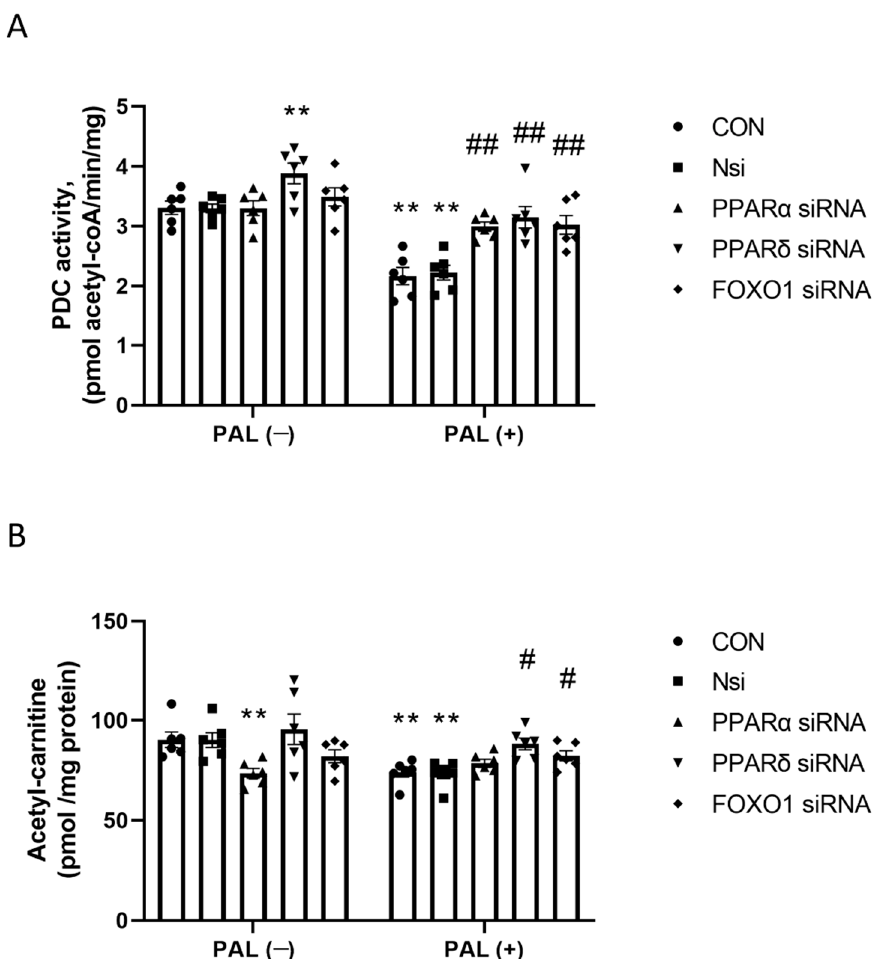
Figure 3. PDC activity ( A ) and acetylcarnitine accumulation ( B ) in C2C12 myotube after individual PPAR α , PPAR δ and FOXO1 siRNA gene silencing in the absence ( left panels ) or the presence of palmitate (PAL; right panels ). Significantly different from control without PAL (CON, ** p < 0.01). Significantly different from CON + PAL ( # p < 0.05; ## p < 0.01). Data represent mean ± SEM of 6 indi- vidual experiments for each intervention group. Nsi—silencer negative control.